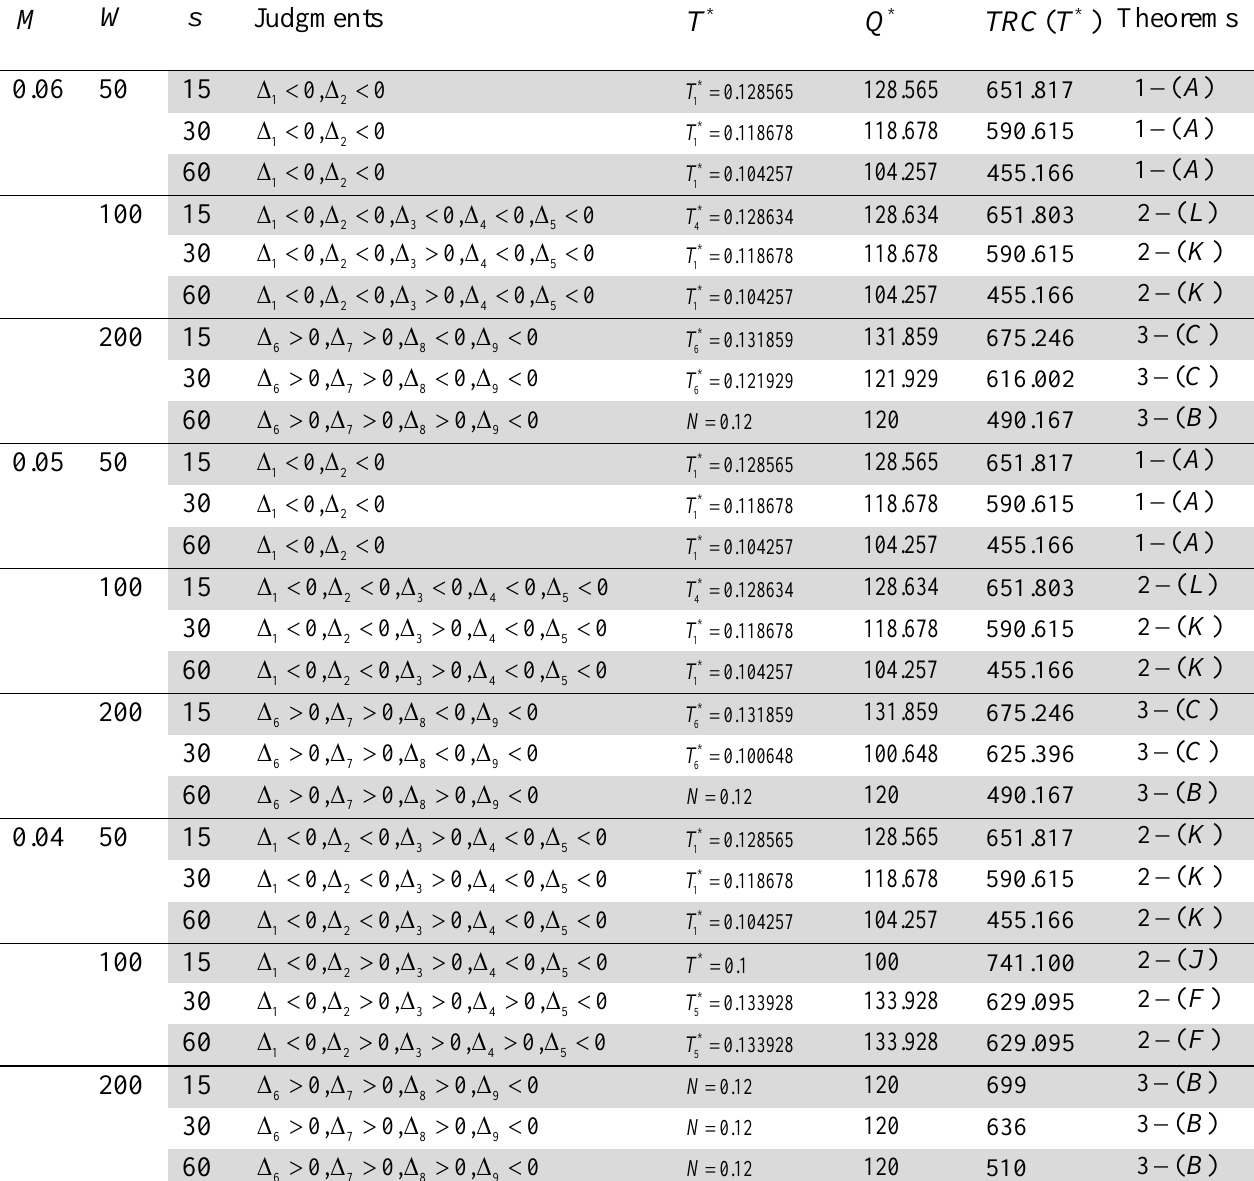
Optimal solutions under dissimilar parametric